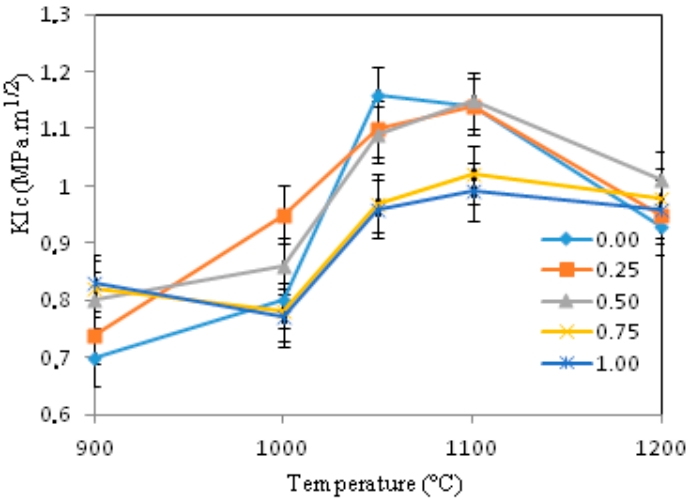
Figure 10. Numerical values of the fracture toughness of Ca 10 − x K x (PO 4 ) 6 F (2 − 2 x ) OH x for 0 ≤ x ≤ 1 sintered at various temperatures.